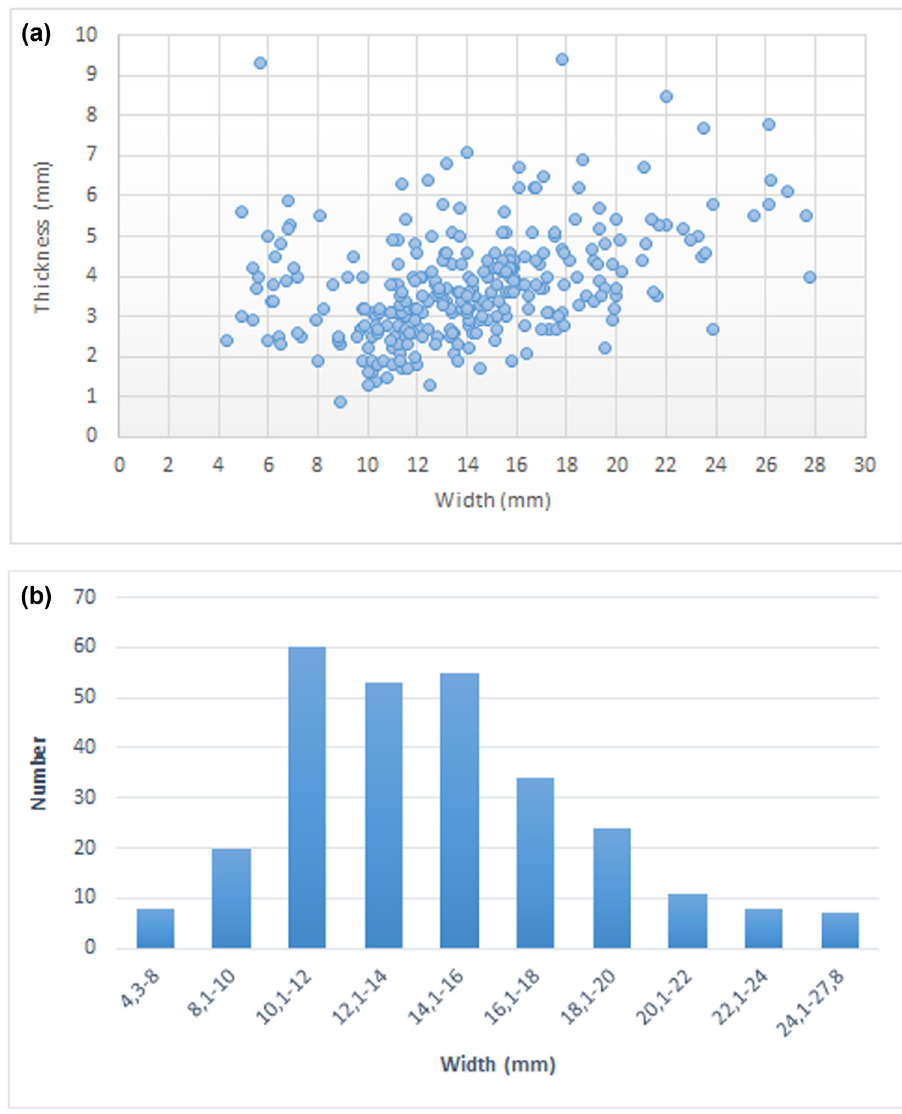
Figure 2: ( a ) Crno Vrilo Sector A: dispersion of the thickness ( ordinate ) and width ( abscissa ) of the Blade products ( n = 280 excluding Blade ( let ) s with very invasive lateral retouch and burin spalls ) ( b ) Crno Vrilo Sector A: Distribution of the Blade ( let ) s according to their width ( n = 280 excluding Blade ( let ) s with very invasive lateral retouch and burin spalls )